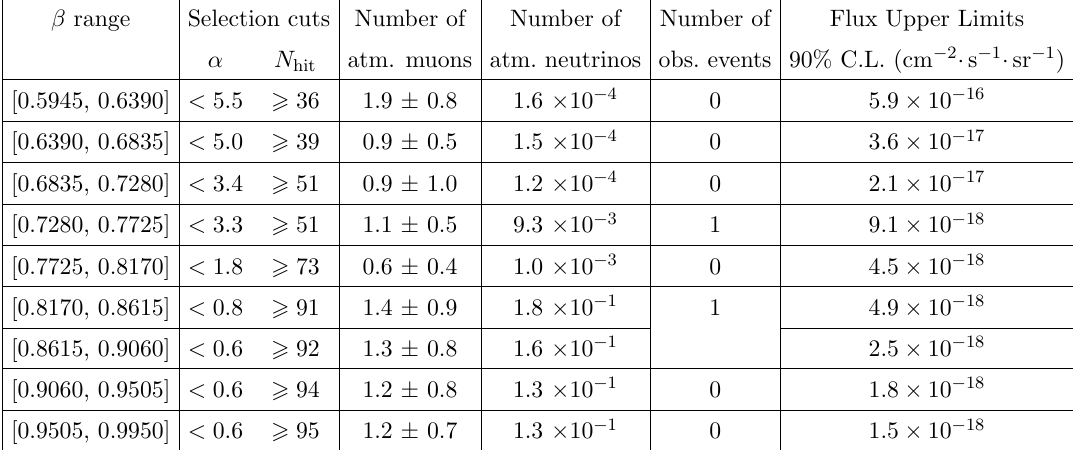
Table 1 . Results after unblinding of the data (1012 active days live time corresponding to 5 years of data taking). The selection cuts, the number of expected (muons and neutrinos) background and observed events and the upper limits on the (cid:13)ux are presented for each range of velocity ( (cid:12) ). The table was divided into two parts to distinguish the (cid:12)rst (cid:12)ve bins where (cid:12) (cid:12)t was assumed as a